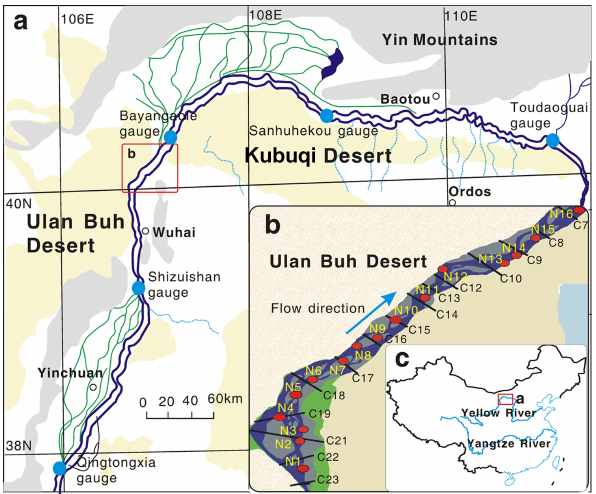
Figure 1. Schematic illustration of the Ulan Buh desert braided channel of the Yellow River, China. (a) The Yellow River flows through the Ulan Buh Desert and the Kubuqi Desert, the braided channel is from Wuhai to Sanhuhekou, and the meandering channel is from Sanhuhekou to Toudaoguai; (b) the studied desert channel; (c) the Yellow River and Yangtze River in China.